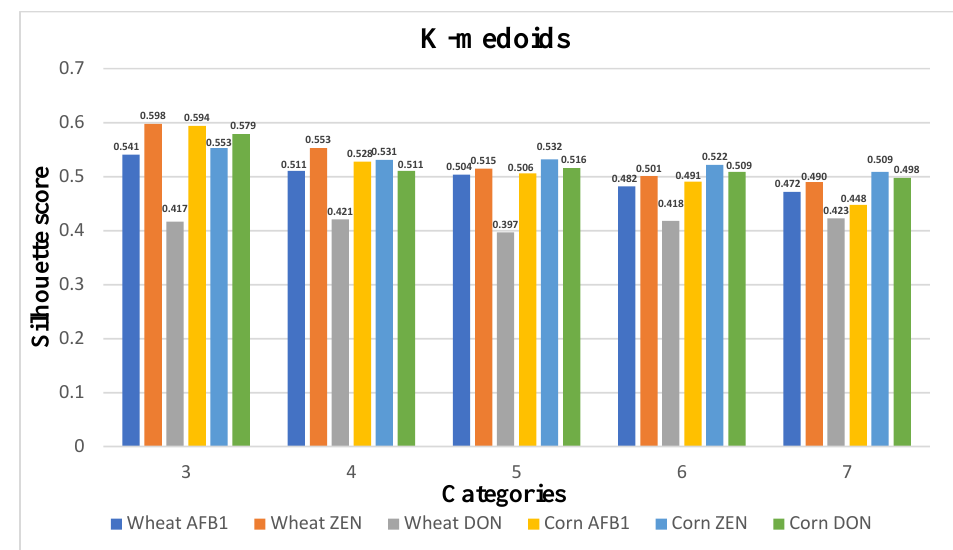
Figure 8. K-medoids; 5 types of clustering category profile coefficients.